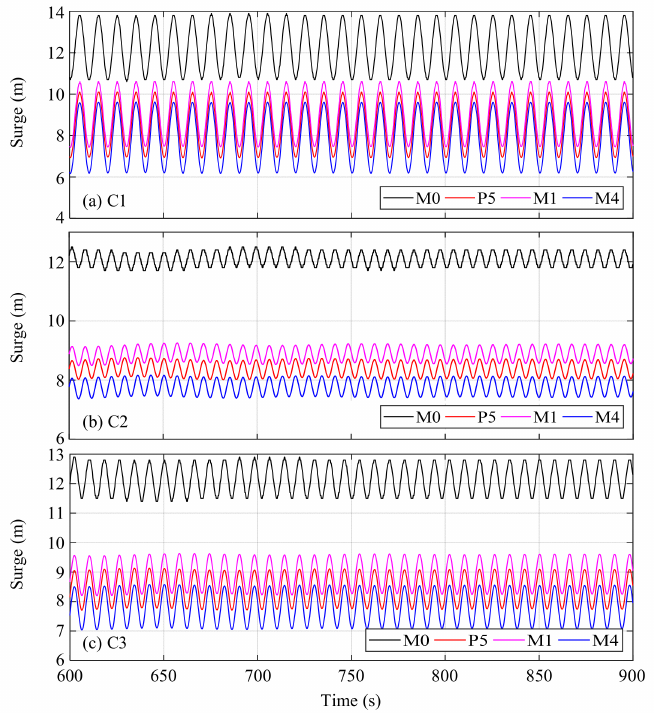
Figure 16. Wind turbine surge movement time series with M0, P5, M1, and M4 when under: ( a ) C1; ( b ) C2; ( c )